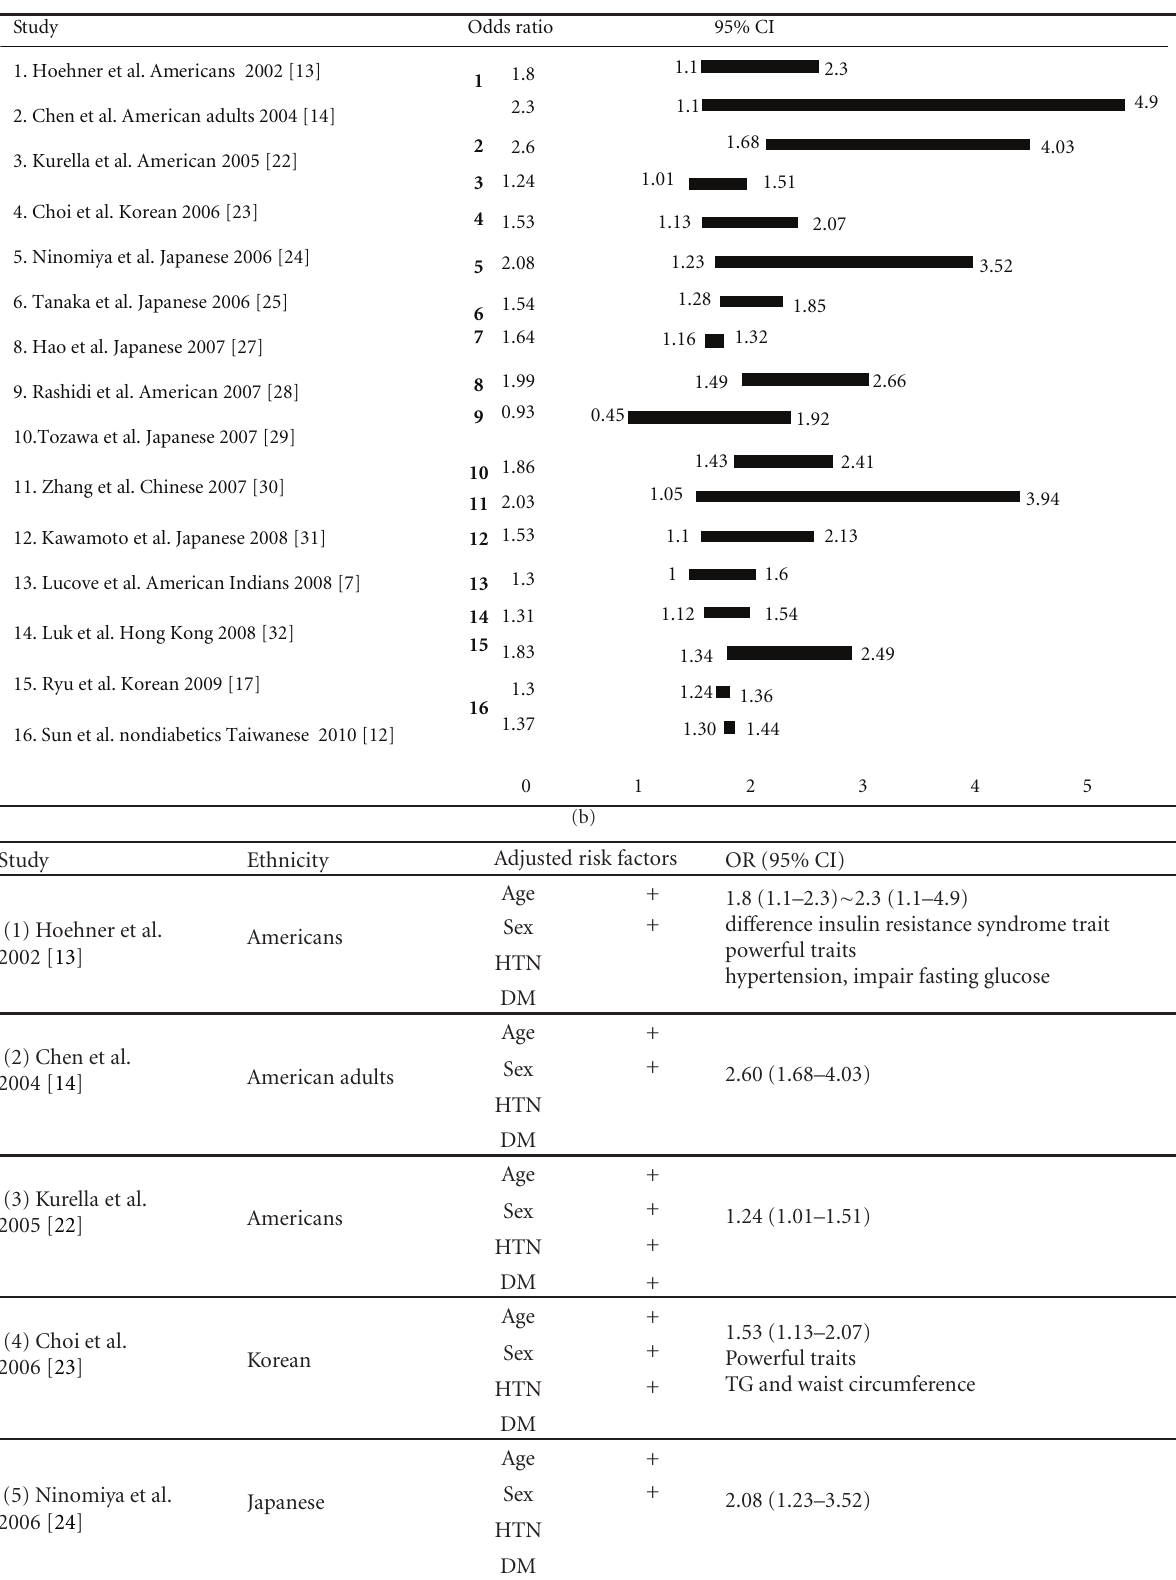
Table 1: OR of CKD in MetS: population-based